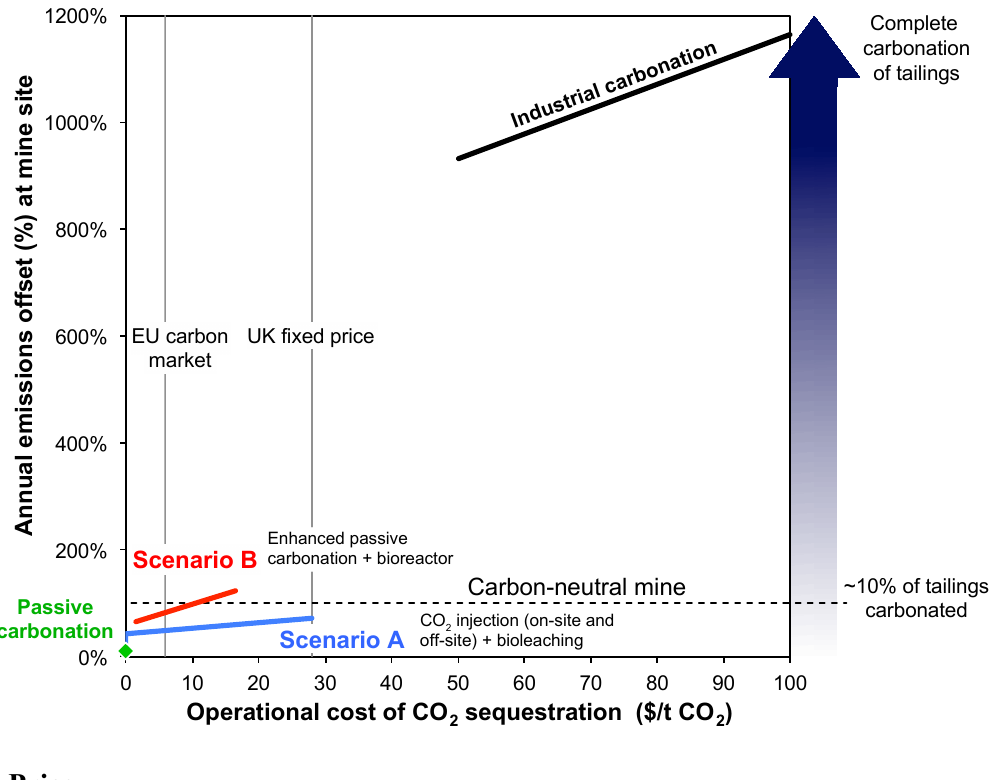
Figure 7. Plot illustrating emissions offset (%) versus cost of CO ) for a mine site based on data for the Mount Keith nickel mine. Plotted technology ($/t CO 2 are passive carbonation, Scenarios A and B, and industrial carbonation along with the EU floating and UK fixed carbon prices. Any new technology is only financially viable when its cost is below the applicable carbon